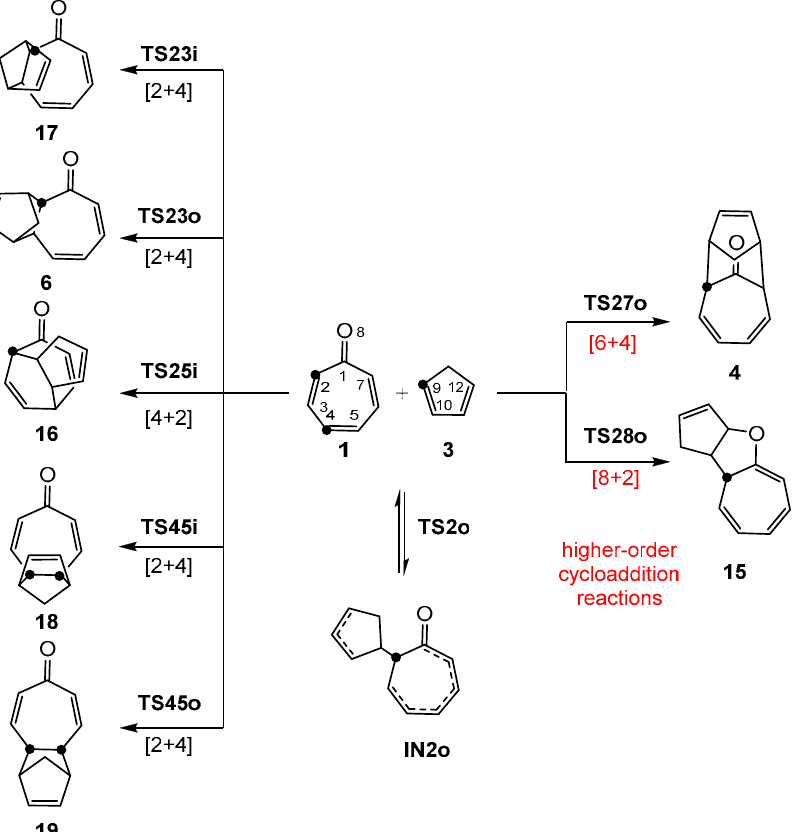
Scheme 5. Competitive reaction paths involved in the cycloaddition reaction of tropone 1 with Cp 3